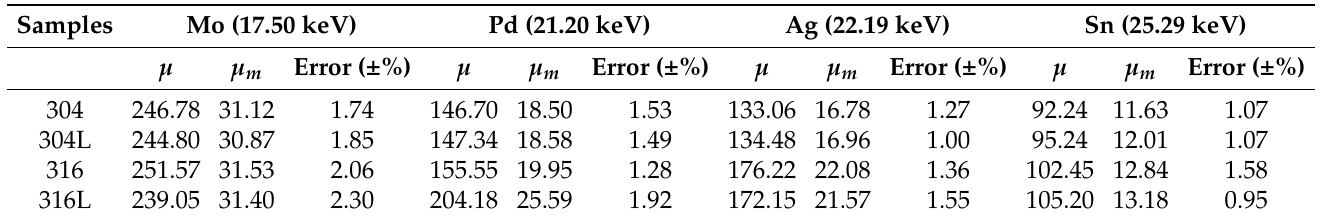
Table 2. Measured linear and mass attenuation coefficients of surgical stainless-steel samples.